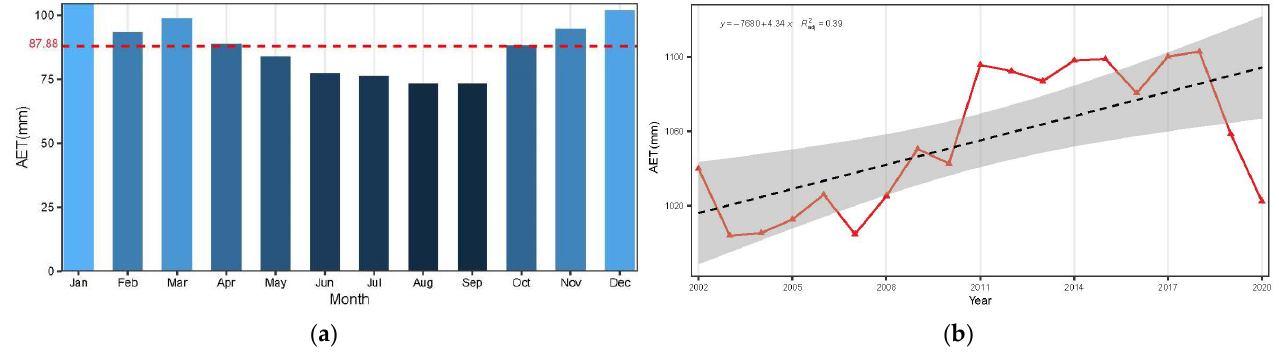
Figure 3. Intra-( a ) and interannual ( b ) variations of AET in South America. Table 2. The statistic value of Z from the MK test and the climate change rate from linear trend regression. Month Z-Value Climate Change Rate